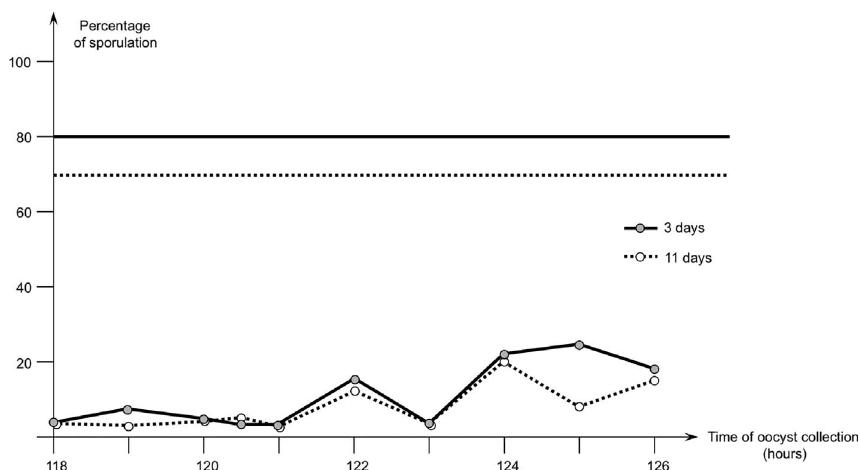
Figure 1. First study with Eimeria meleagrimitis – evolution of the percentage of sporulation of oocysts of E. meleagrimitis (PM3 strain) collected in the duodenum from 118 to 126 hours after infection. Percentage of sporulation was evaluated after incubation for 3 or 11 days at 28 (cid:3) C. The horizontal straight lines show the percentage of sporulation observed among oocysts collected in droppings 144 h after infection.